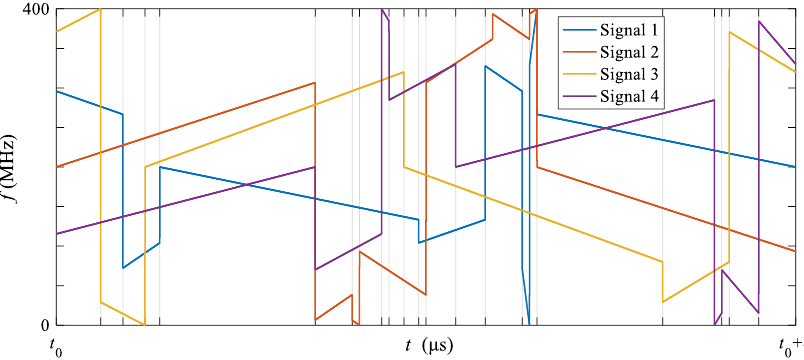
Figure 8. Time-frequency structure of the transmit signals of the OFDM-NLFM waveform set ob-